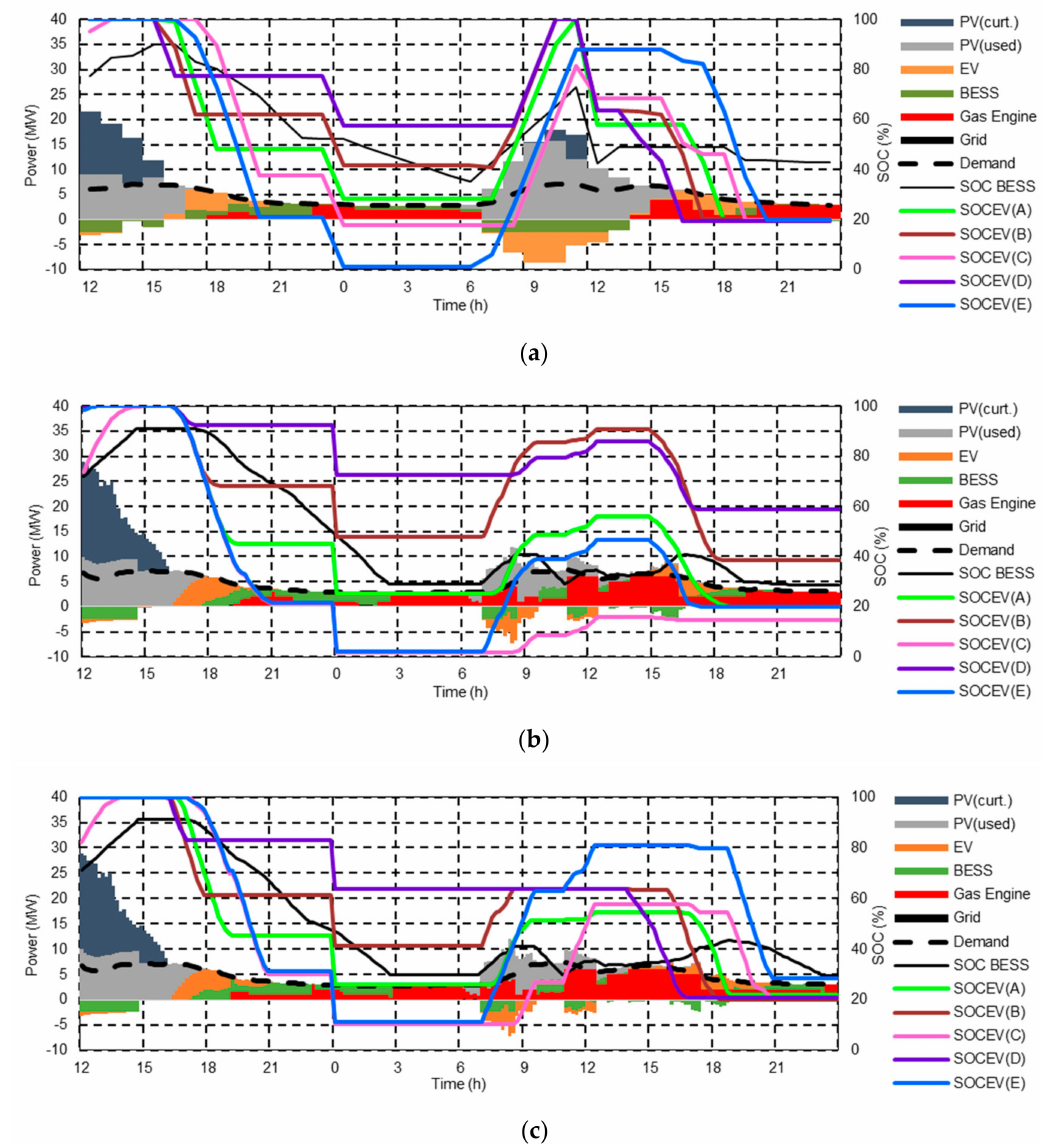
Figure 12. US–TED simulation on 30 March (Thursday) and 31 March (Friday): ( a ) US results, ( b ) TED result of Case B (EV variety w/o priority) and ( c ) TED result of Case C (EV variety with